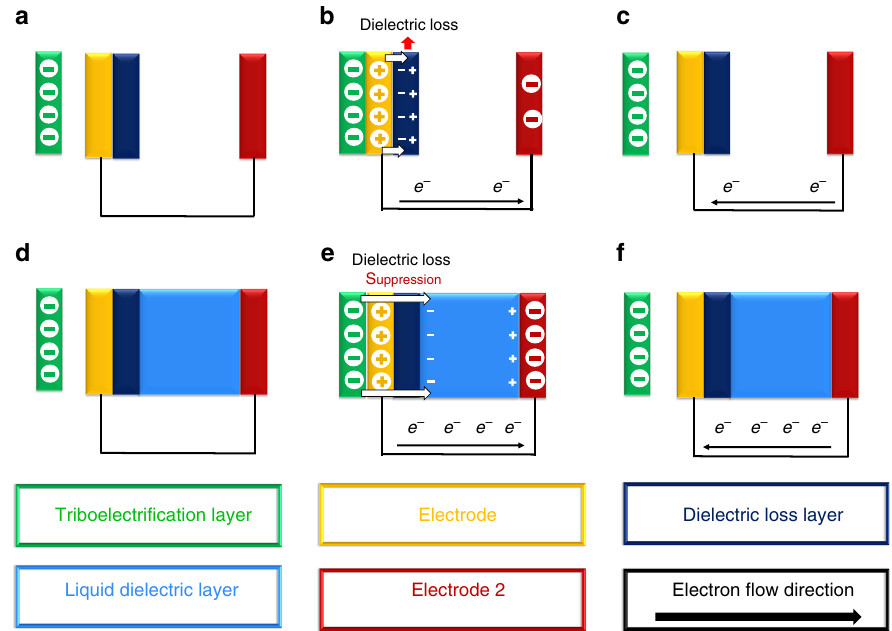
Fig. 3 Conformation and process of triboelectric generator. a Equilibrium state of a TEG without liquid dielectric layer. b Contact state without liquid dielectric layer. c separation state without liquid dielectric layer. d Equilibrium state of a TEG with liquid dielectric layer. e Contact state with liquid dielectric layer; and f separation state with liquid dielectric